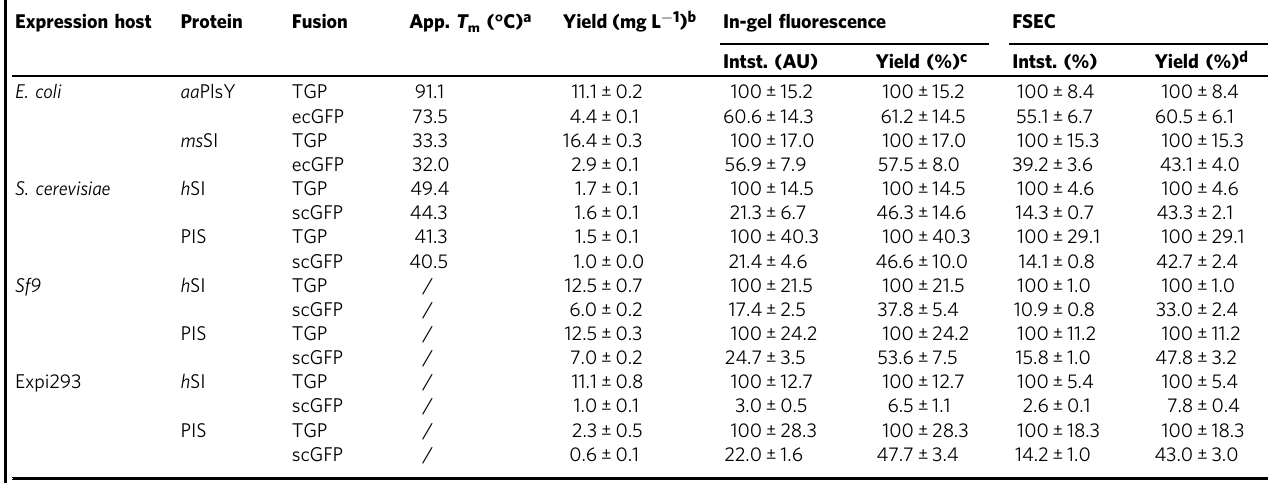
Table 1 Comparison of TGP with GFPs for FSEC-TS assay and membrane protein expression. Expression host